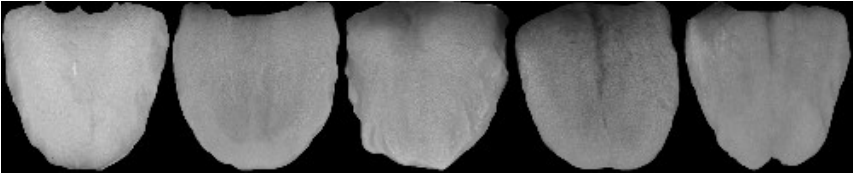
Figure 9. Some samples of dataset 2.